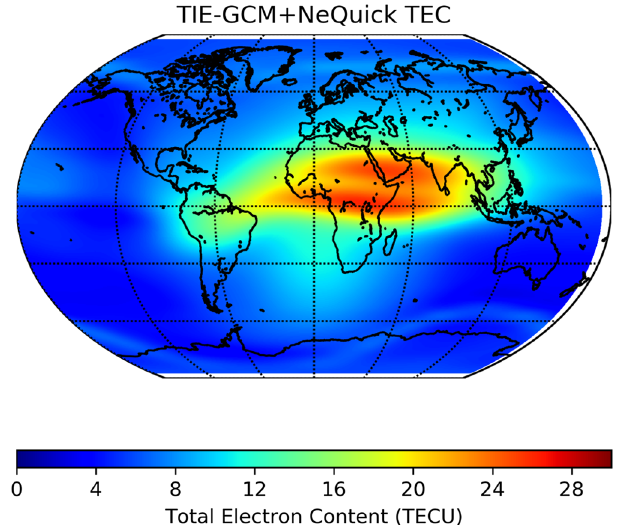
Fig. 5. TEC map for June 5th at 1230 from TIE-GCM+.